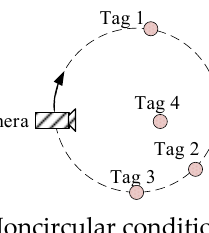
Figure 7 . Simulation conditions.